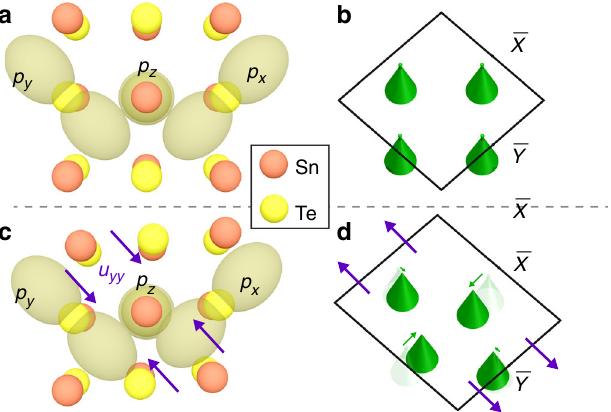
Fig. 5 The effects of orbital overlap on the electronic band structure in TCIs. Schematic of the relevant orbitals: a in the absence of any distortion, and c under strain along y -axis. The view shown is a top view of the (001) direction of the lattice with the top two layers represented by slightly shifted atoms. The P x and P y orbitals belong to the top layer Te atoms, whereas the p z orbital belongs to a second layer Te atom. b , d The positions of the four Dirac cones (green) within the fi rst Brillouin zone related to the atomic structure in a , c , respectively. As seen in c , strain in y -direction increases the “ overlap ” of p x and p z orbitals, whereas the overlap of p y and